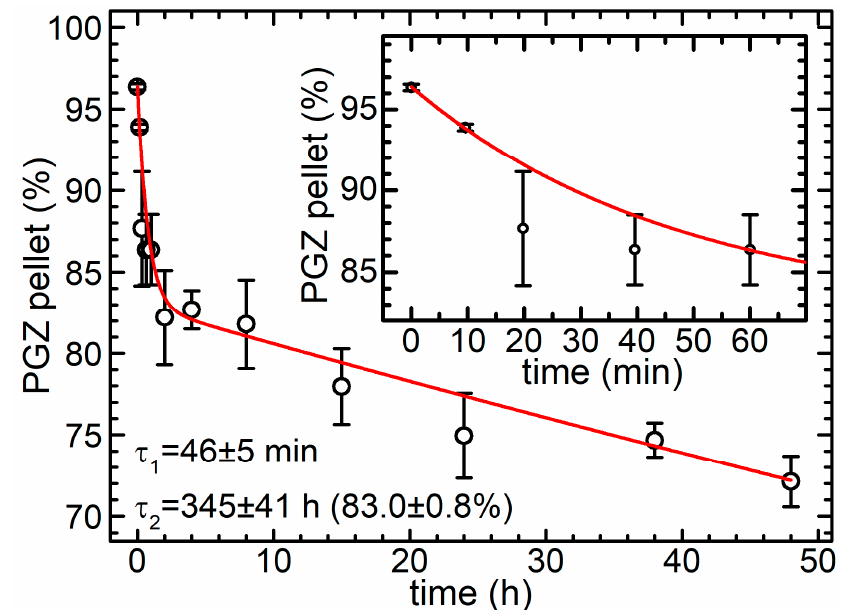
Figure 5. Percentage of PGZ remained inside PGZ-loaded PLGA NPs (developed via nanoprecipitation method) in phosphate-buffered saline (PBS) buffer at 37 °C as a function of time; error bars are standard deviations (n = 2), red line is a fit with a double-exponential decay to 0, the inset is a zoom of the graph in the first 70 min.